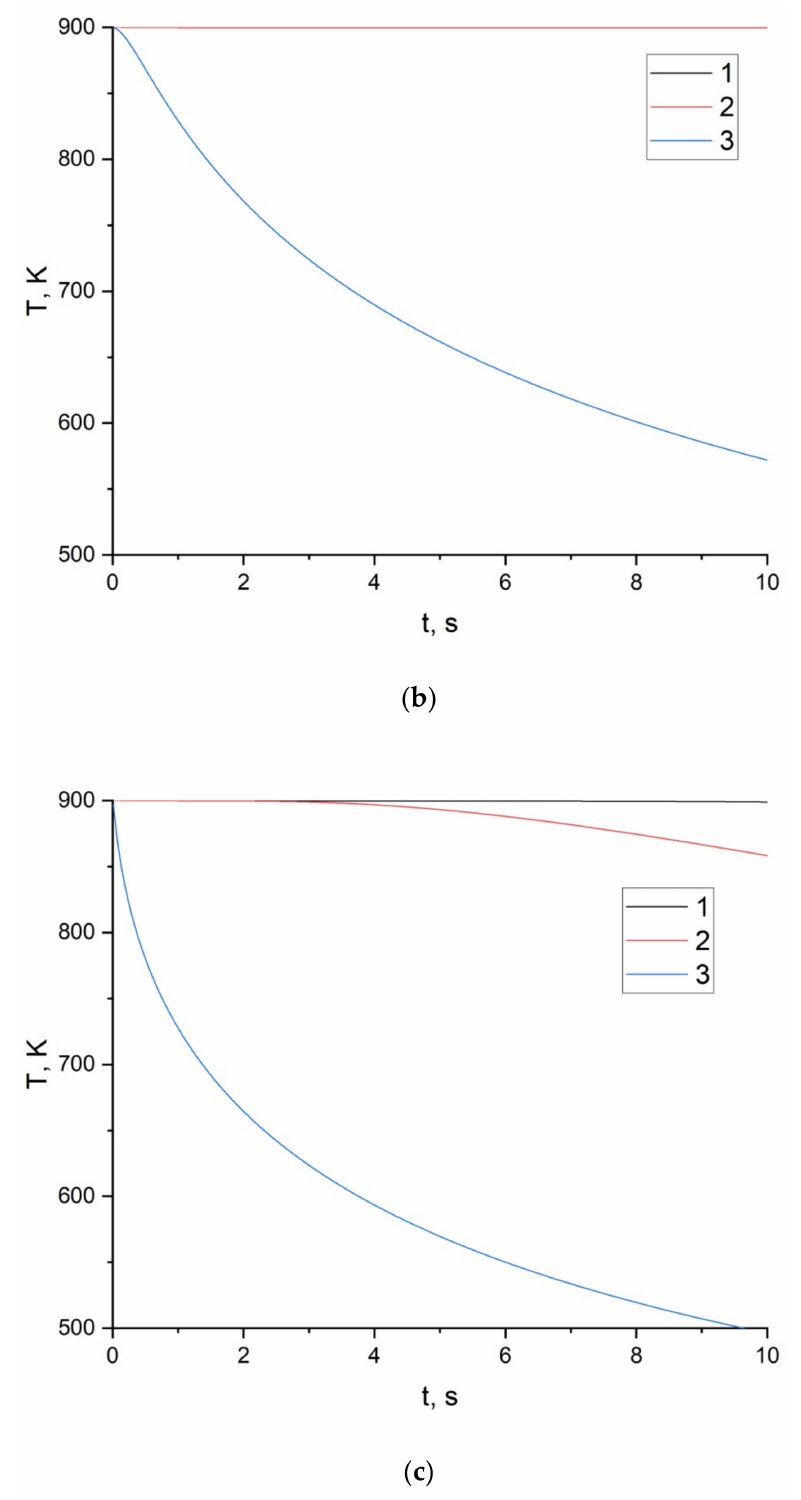
Figure 5. Dependence of temperature on time at different points of the firebrand for different firebrand sizes: ( a ) transverse dimension 10 cm; ( b ) transverse dimension 5 cm; ( c ) transverse dimension 1 cm; curves 1: in the center of the firebrand; 2: first quarter; 3: on the border of the